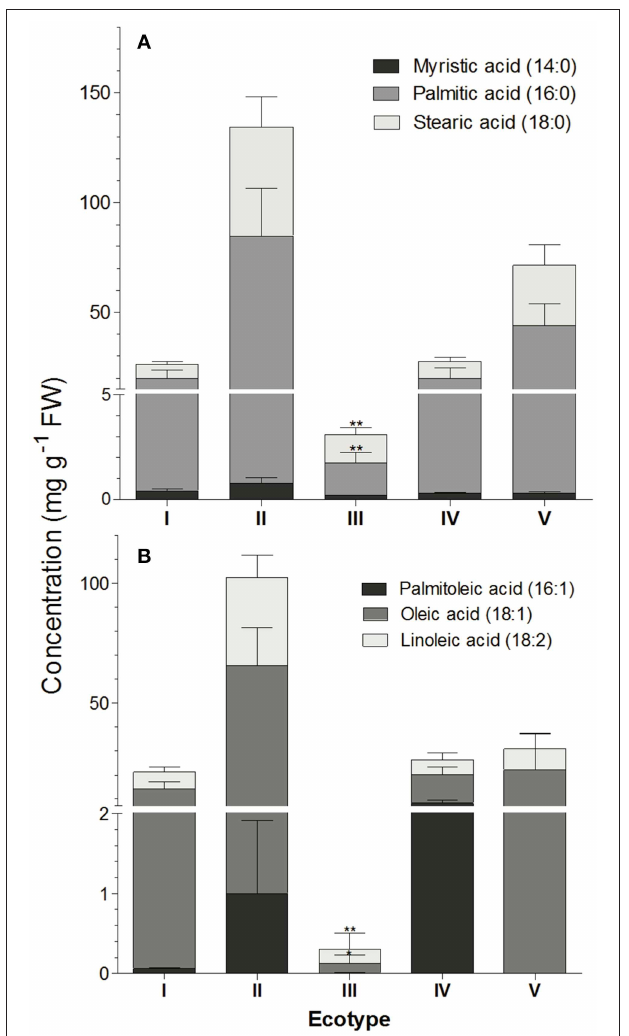
FIGURE 4 | Fatty compositions of R. communis elaiosomes. (A) Saturated fatty acids and (B) Unsaturated fatty acids. Data represents mean ± SE (mg g − 1 FW) of the fatty acids measured using GCMS analysis. Bonferroni’s post-hoc test was done to separate the means after two-way ANOVA. Asterisk indicates points of significant difference between ecotype III and others ( p ≤ 0.01, n = 4).